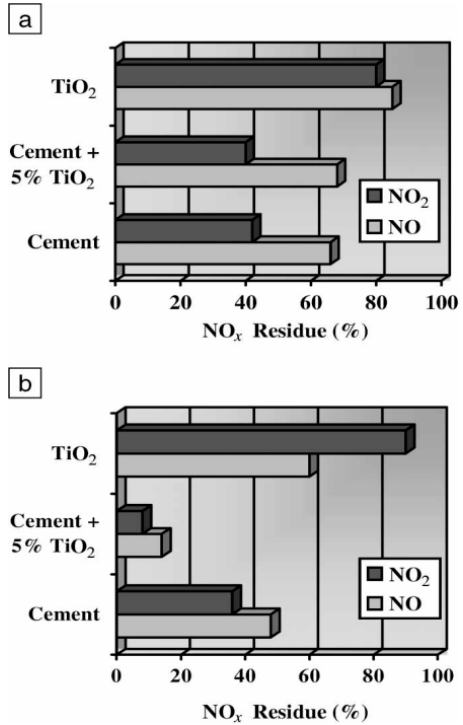
Figure 46. Laboratory tests of the anatase TiO 2 photocatalytic cement-based products used in the precast concrete panels in the sails of the Dives in Misericordia Church (Rome): ( a ) under dark conditions; and ( b ) under UV irradiation for 7 h. Note the increased reduction of NO and NO 2 under UV irradiation. Reproduced with permission from Cassar [139]. Copyright 2004 by the Materials Research Society (License No.: 4453250907572).